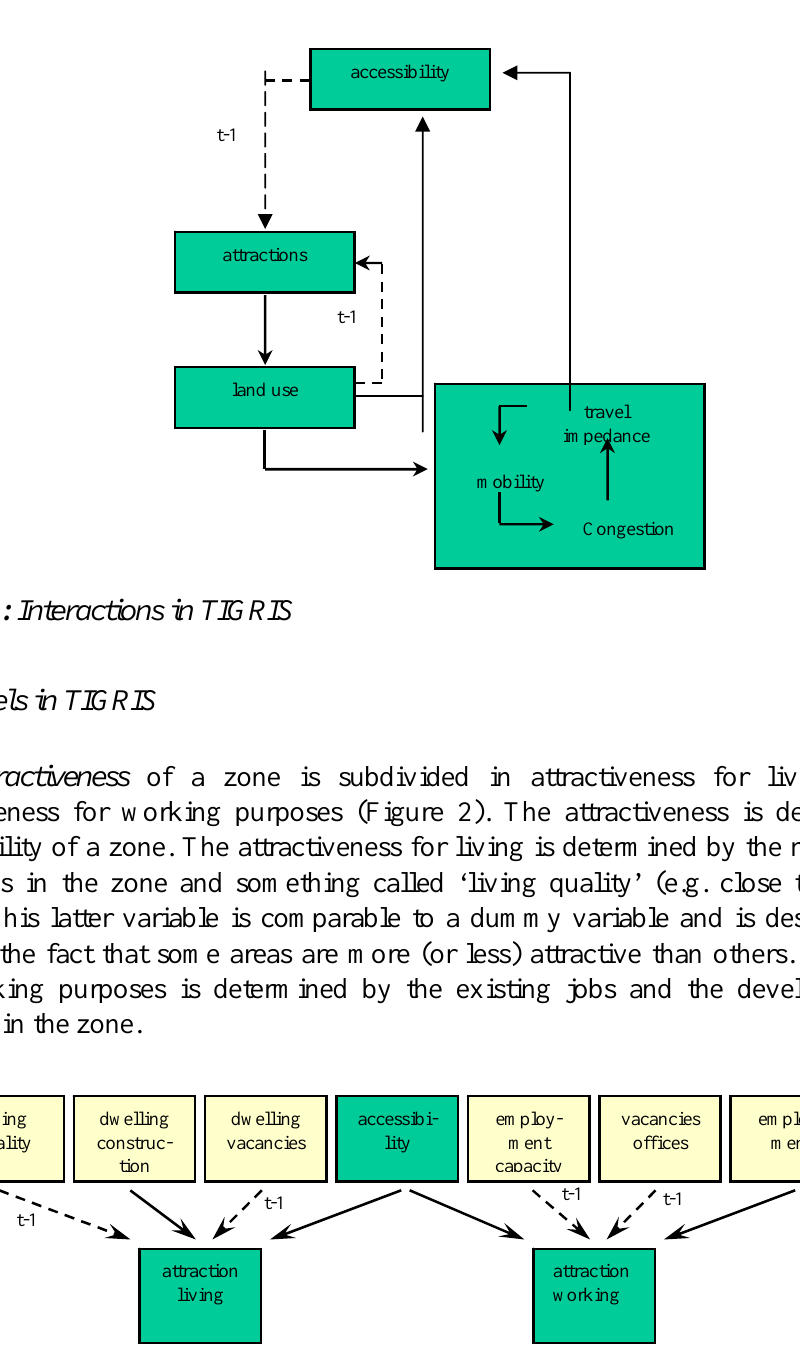
Figure 2. Attractions